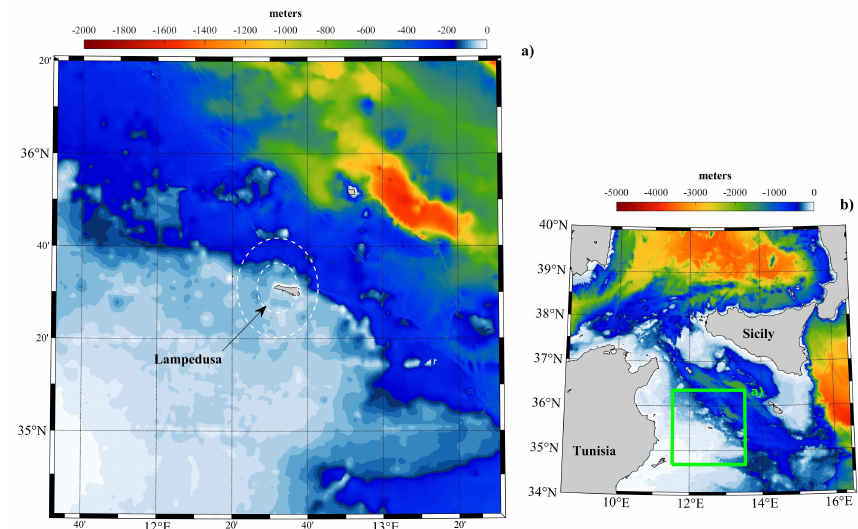
Figure 6. Bathymetry maps (color scales) of the ( b ) Mediterranean region of our interest and ( a ) detail around Lampedusa island. The latter region is also marked as green square in panel ( b ). White dashed circles, both centered at LMP observatory, indicate 10 and 20 km distant points. Different color scales are used for a better recognition of regional bathymetry. Map produced by M_Map software